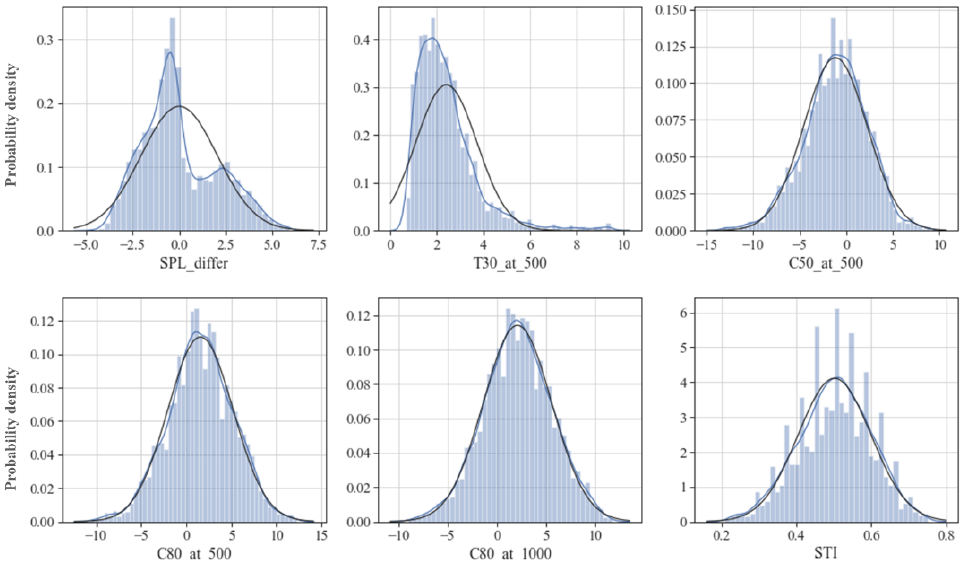
Figure 12. The distribution of target values.